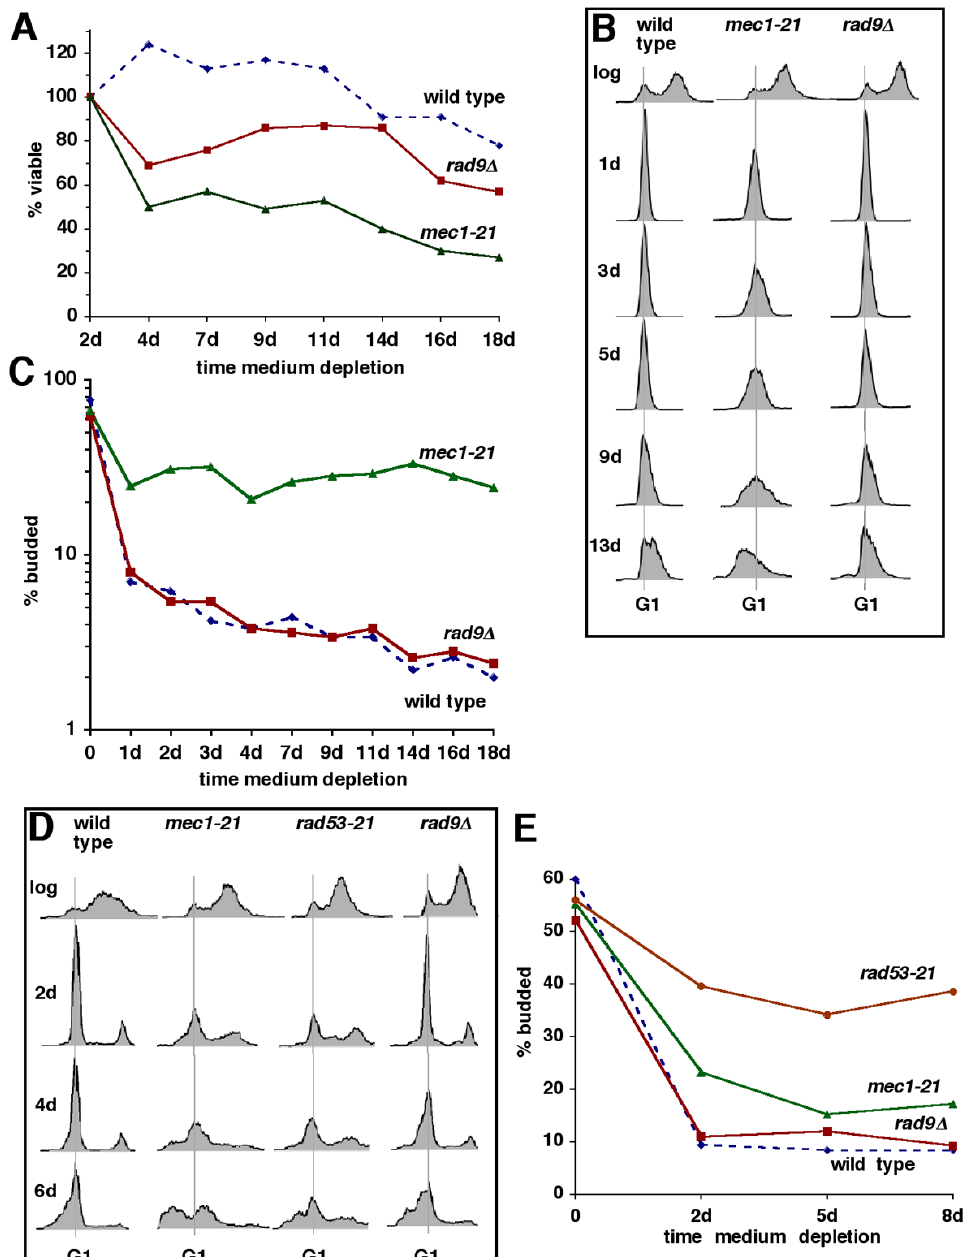
Figure 3. Nutrient depletion induces DNA replication stress. A–C. Viability ( A ), DNA content ( B ) and budding index ( C ) of wild-type (W303) cells and cells with mutations in MEC1 or RAD9 undergoing nutrient depletion in YPD medium. D&E. DNA content ( D ) and budding index ( E ) of wild-type, mec1-21 , rad53-21 and rad9 D cells undergoing nutrient depletion in SC medium.